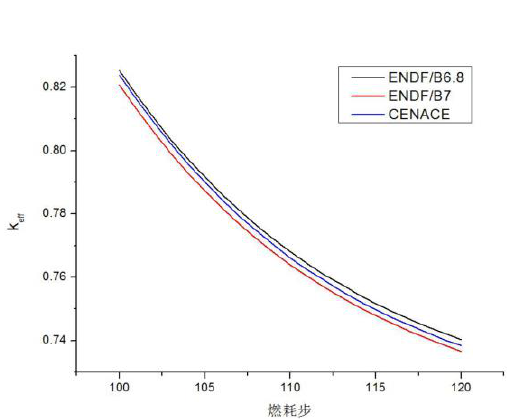
Fig.9. The results of AFA3G31000 assemble from steps 80 to 120